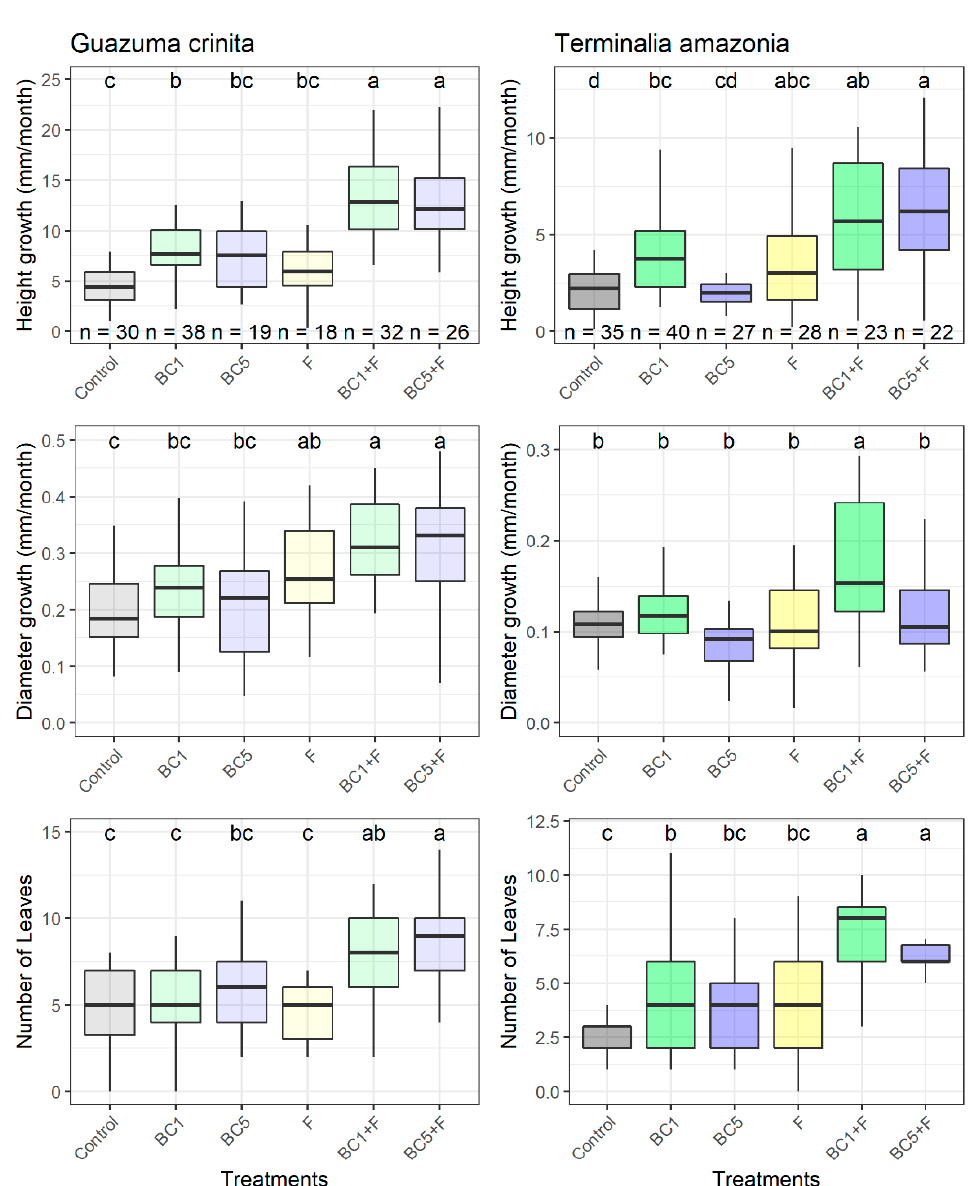
Figure 2. Height and diameter species growth, and final number of leaves across six different biochar treatments (BC1 = Biochar 1 kg/plant; BC1 + F = Biochar 1 kg/plant + Fertilizers; BC5 = Biochar 5 kg/plant; BC5 + F = Biochar 5 kg/plant + Fertilizers; Ctrl = Control; F = Fertilizers). Different letters above each plot represent significant statistical differences, ANOVA + TUKEY post hoc ( p < 0.05). The end of the upper (lower) whisker represent the largest (smallest) value within 1.5 times interquartile range above (below) 75th (25th) percentile, as defined by the ggplot2 package of R software version (3.5.1) [36].